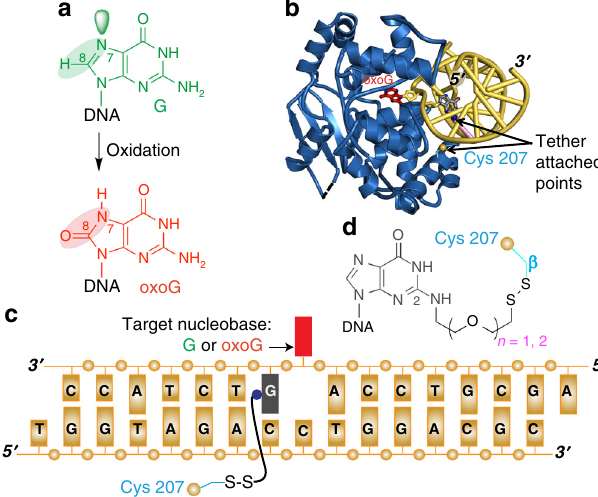
Fig. 1 Generation of 8-oxoguanine and experimental strategy used to capture hOGG1 interrogating DNA. a Structural comparison of G versus oxoG. b Structure of un-crosslinked lesion-recognition complex, LRC 16 , of hOGG1 (cyan) bound to oxoG containing DNA (red). Blue sphere on the guanine (gray) represents the point of thiol-tether attachment and the yellow sphere represents Cys residue used for crosslinking. c Schematic DNA sequence diagram illustrating the crosslinking site in relation to the target nucleobase. d Attachment of the thiol-tether at the N2 position of guanine, with the tether protruding into the minor